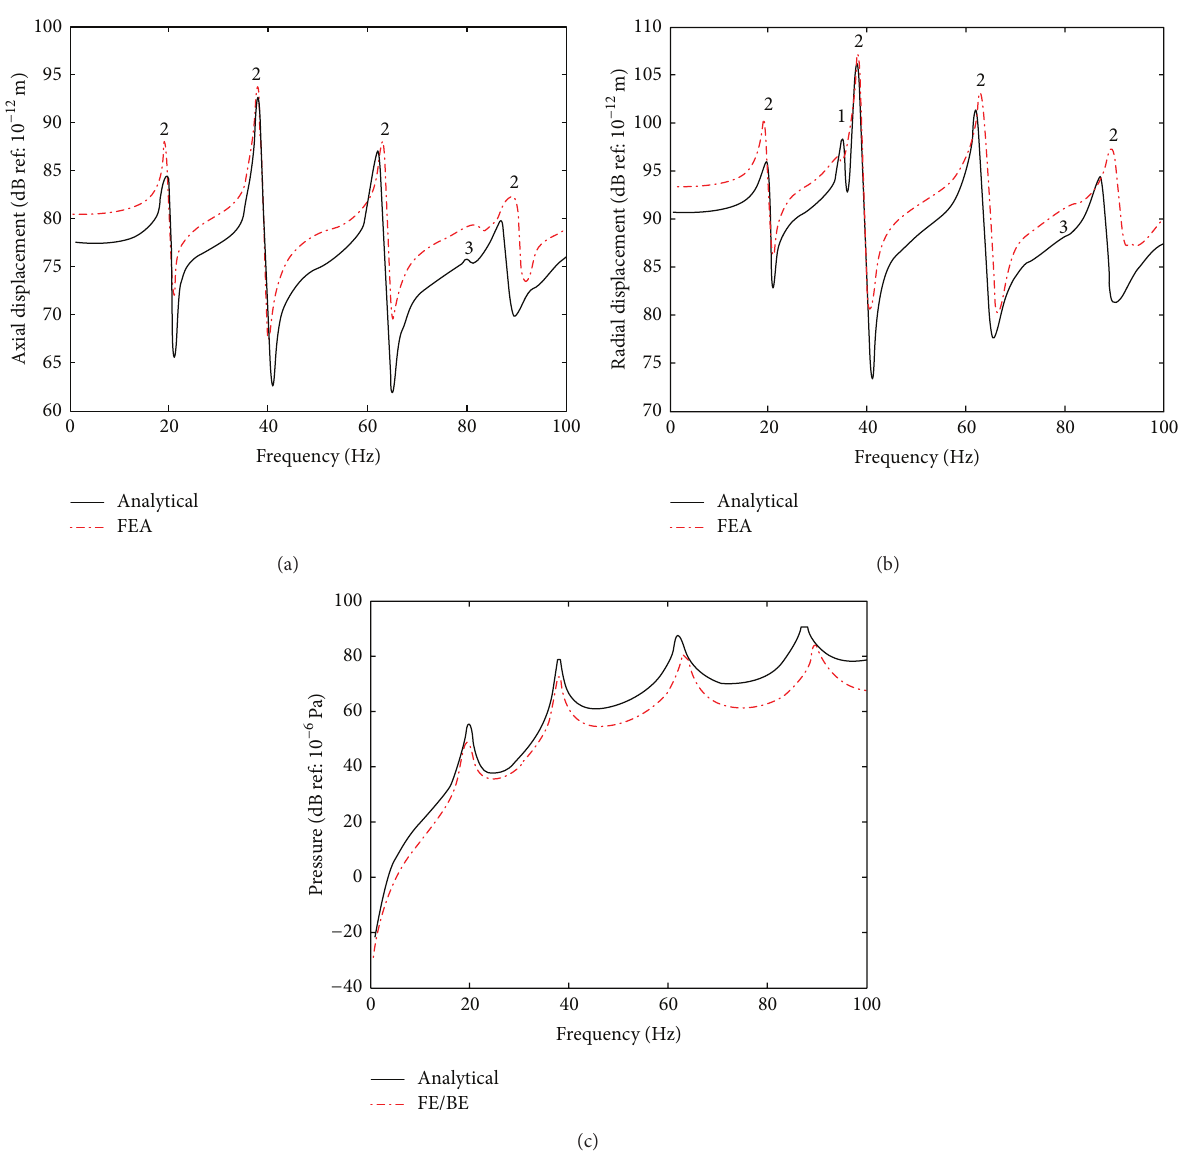
Figure 10: Structural and acoustic responses due to 𝐹 2 (a) axial displacement, (b) radial displacement, and (c) far-field pressure. is of the same order as the distance between the